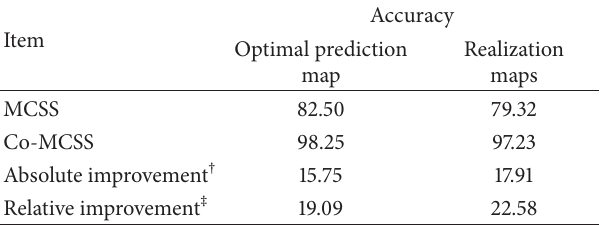
Table 2: Percentages of correctly classified locations (PCCs) of optimal prediction maps and simulated realizations (averaged from 100 realizations) generated by Co-MCSS and MCSS. PCCs (%) are estimated relative to the reference soil map with sample data being